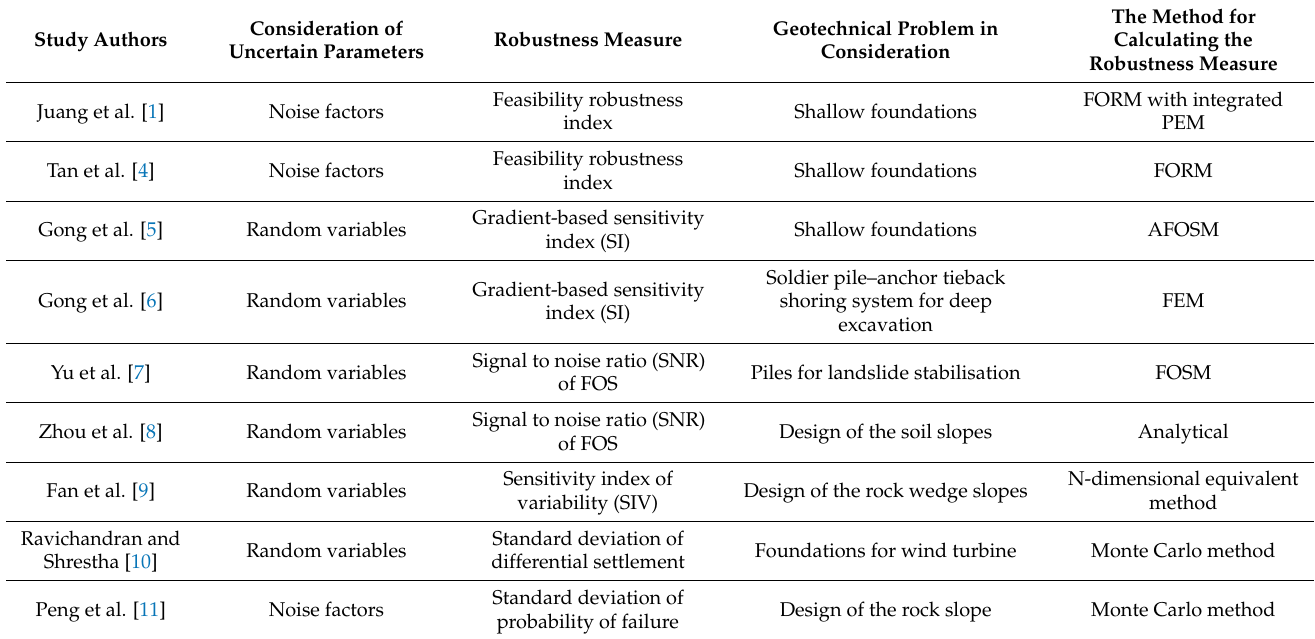
Table 1. The summary of reviewed